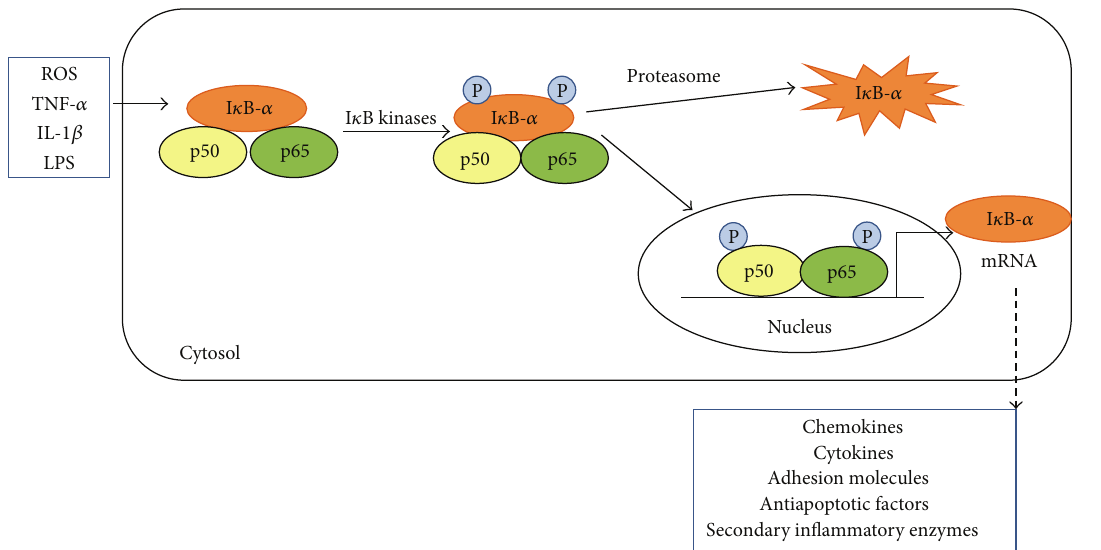
Figure 1: The NF- 𝜅 B signaling pathway (see text for